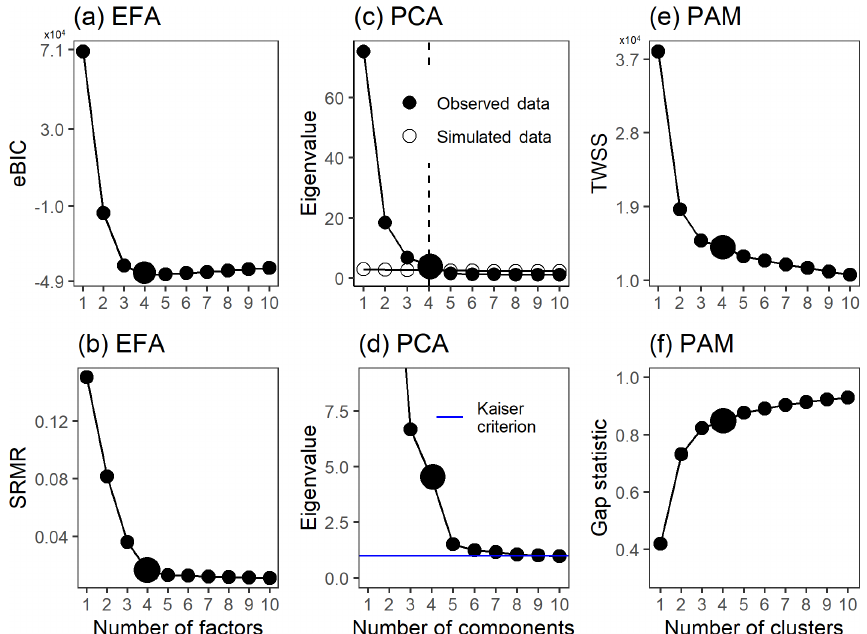
Figure 1. Factor number indices for gas-phase data (PTR-MS). Empirical BIC (a) and SRMR (b) as a function of the number of factors for ml-EFA. Parallel analysis (c) and Kaiser criterion (d) for EVD-PCA and TWSS (e) and gap statistic (f) for PAM. Larger points indicate the solution that was selected for more detailed interpretation.